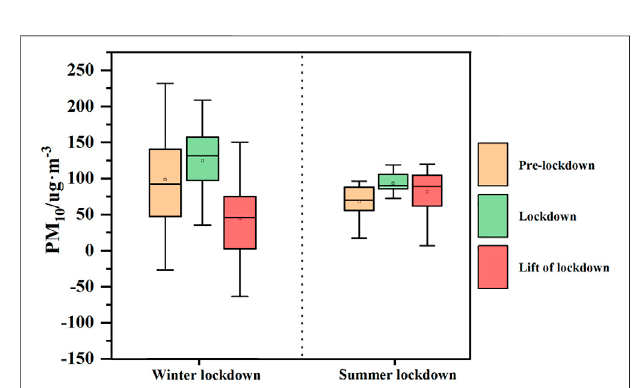
FIGURE3| DeviationbetweenhistoricalandlockdownperiodsforPM 10 concentrations during the winter and summer lockdowns in Urumqi.